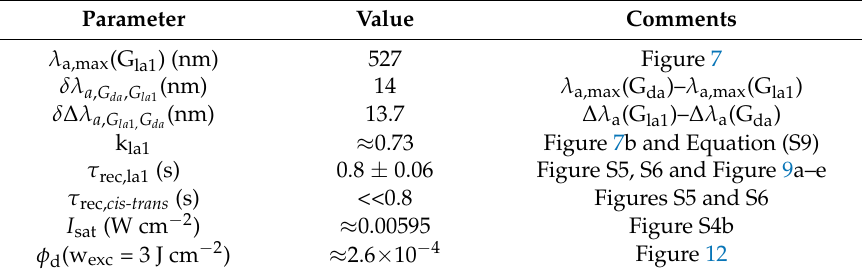
Table 3. Secondary photo-isomerization and protein restructuring photocycle of CaRh in pH